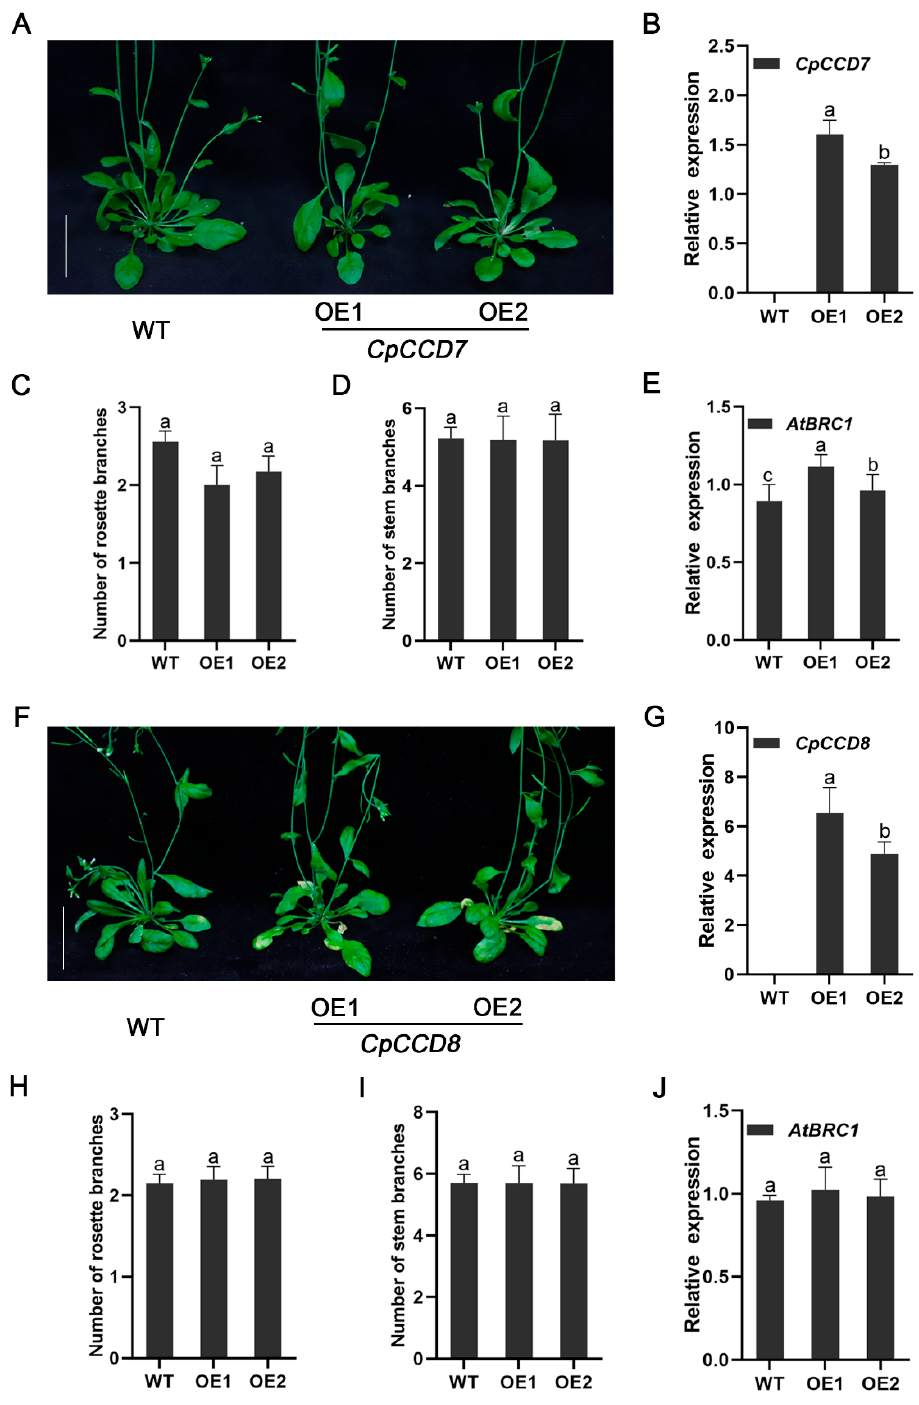
Figure 5. Branching phenotype of CpCCD7-OE and CpCCD8-OE lines. ( A ) Rosette branching phenotype of CpCCD7-OE plants at 35 d after transplant. ( B ) Expression level of CpCCD7 in transgenic and WT plants. ( C ) Number of rosette branches in CpCCD7-OE lines and the WT. ( D ) Number of stem branches in CpCCD7-OE lines and the WT. ( E ) Expression level of AtBRC1 in CpCCD7-OE lines and WT. ( F ) Rosette branching phenotype of CpCCD8-OE plants at 35 d after transplant. ( G ) Expression levels of CpCCD8 in transgenic and WT plants. ( H ) Number of rosette branches in CpCCD8-OE lines and WT plants. ( I ) Number of stem branches in CpCCD8-OE lines and WT plants. ( J ) Expression level of AtBRC1 in CpCCD8-OE lines and WT plants. Data represent the mean ± standard deviation (SD; n = 20–60). In ( A , F ), scale bars = 3 cm. In ( B – E , G – J ), different lowercase letters (a,b) above the bars indicate significant differences ( p < 0.05).